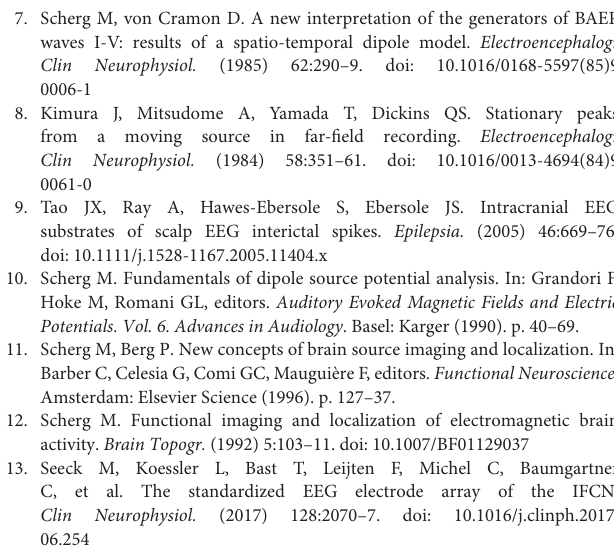
Supplementary Figure 1 | Assessment of focality: Nine IEDs (1-s segments) are shown in scalp space (middle) and standard source space 25 (top). The visual impression of higher focality in source as compared to scalp space, i.e. the IED signal spreads less and with smaller magnitude over the channels in source than scalp space, is quantified by the new measure of focality F(n) summing the cumulative variance of the correlation with the largest signal from the largest to the n-th largest channel (see Materials and Methods). The focality diagrams at the bottom show focality in % for segments 2 (left) and 5 (middle). In segment 2, focality is considerably larger in source space at lower n-values while the more widespread IED in segment 5 exhibits similar focality in source and scalp space. The diagram at the lower right depicts source focality together with the difference of focality in source vs. scalp space over the 65 left temporal IEDs of the mTL patient shown in Figure 11 . The difference is > 0 in all but 2 IEDs. This proves the much higher focality in source space ( p <